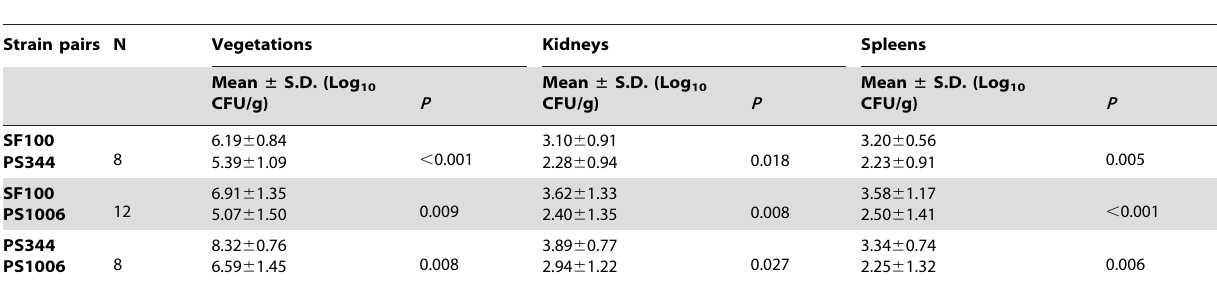
Table 1. Impact of lysin expression on virulence in a rat model of infective endocarditis.